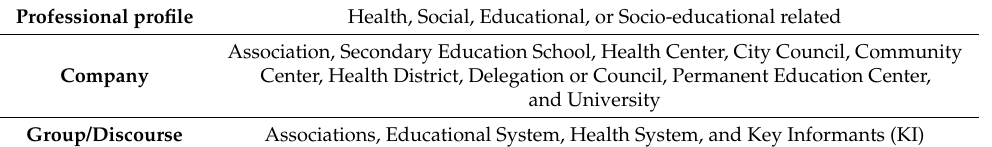
Table 2. Sample “Professionals”